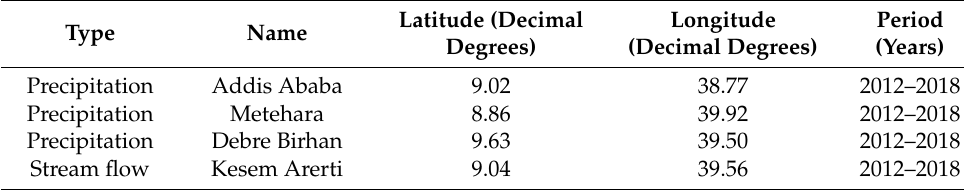
Table 2. List of selected meteorological and hydrological gauge